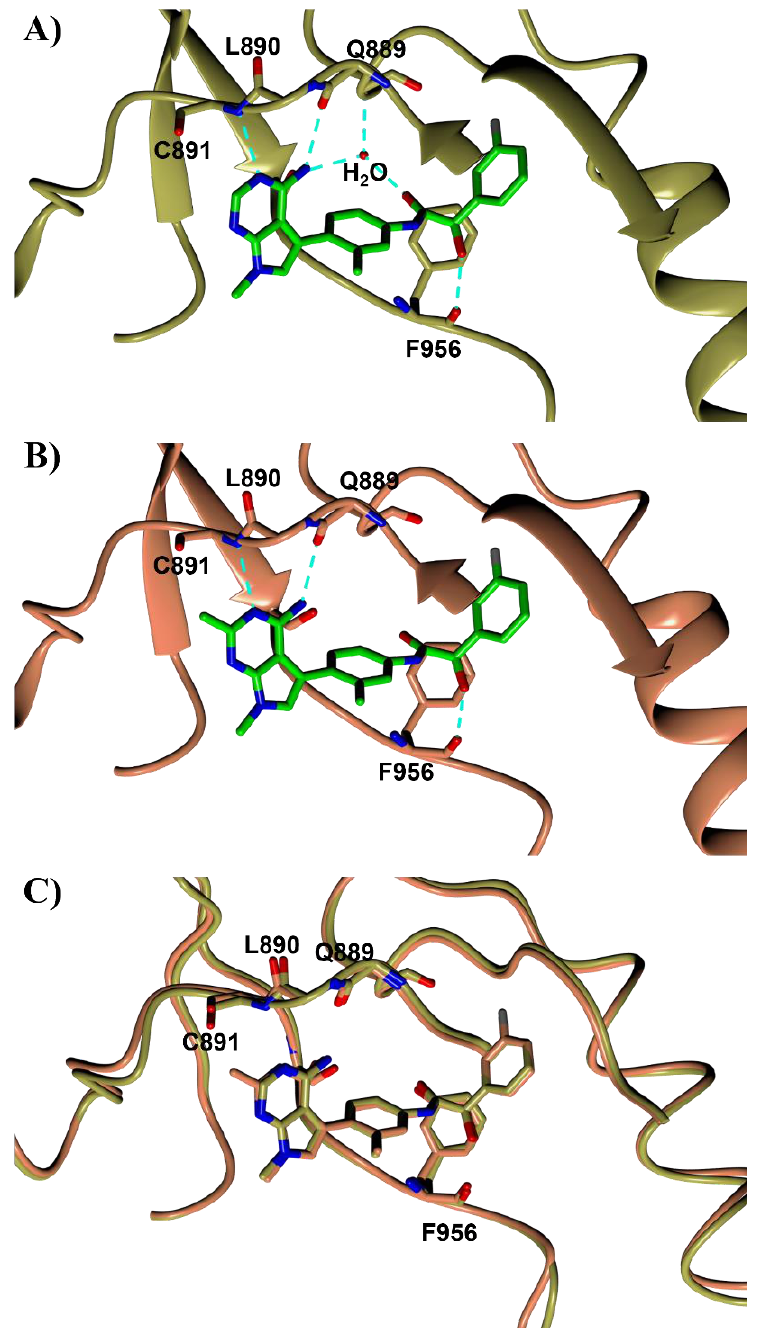
Figure 1. Crystal structures of PERK with selected inhibitors 11 ( A ) and 24 ( B ). Overlay of the crystal structures of 11 and 24 ( C ). The same orientation is presented for all panels. The PERK backbone is shown as a ribbon or solid strand in yellow for 11 and coral for 24 . The side chains are depicted as cylinders in the same color as the main chain for carbon, blue for nitrogen, and red for oxygen atoms. Inhibitors are shown as cylinders with same color scheme except green for carbon in panels ( A , B ) and grey for fluorine. Hydrogen bonds are shown as cyan dashed lines.